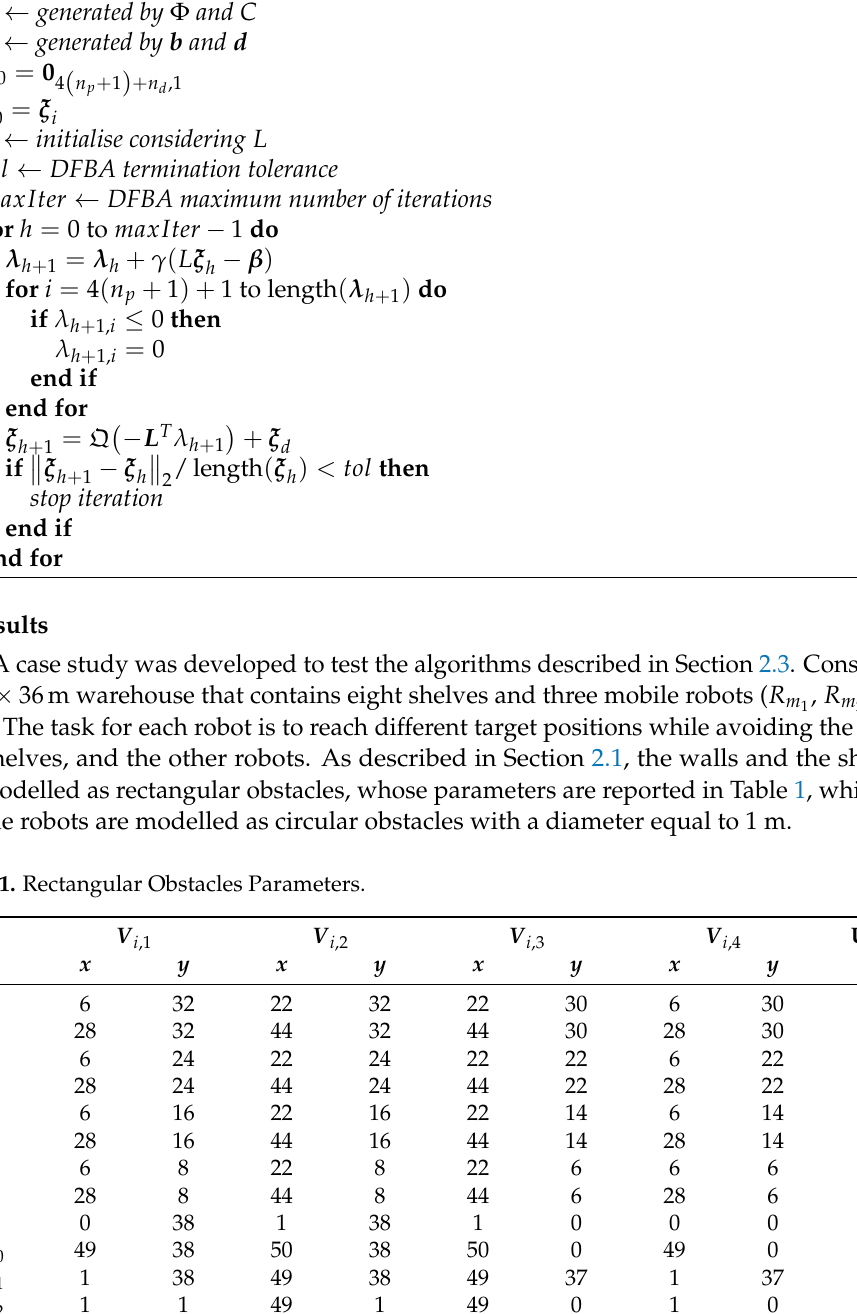
, ξ , Q , Φ , b , C , d ) i d